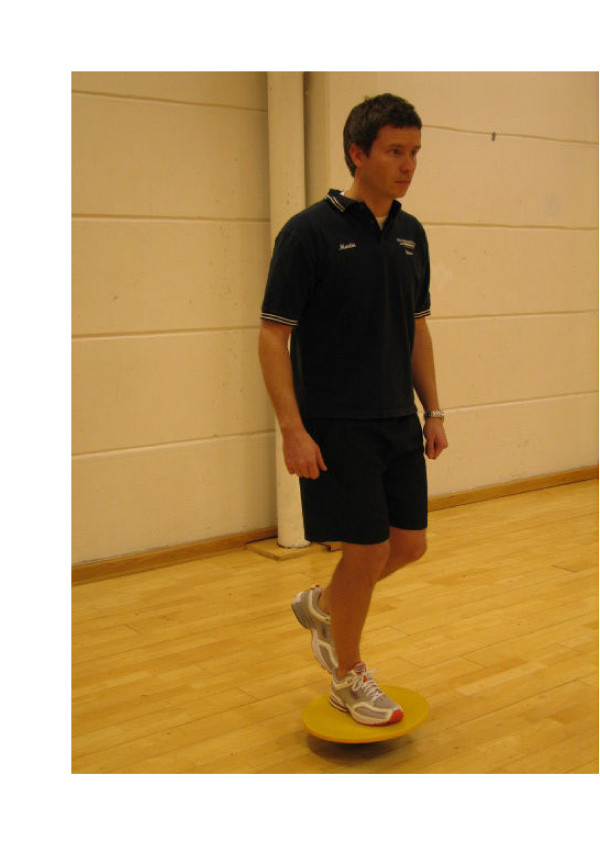
Balancing on one leg on a balance board.